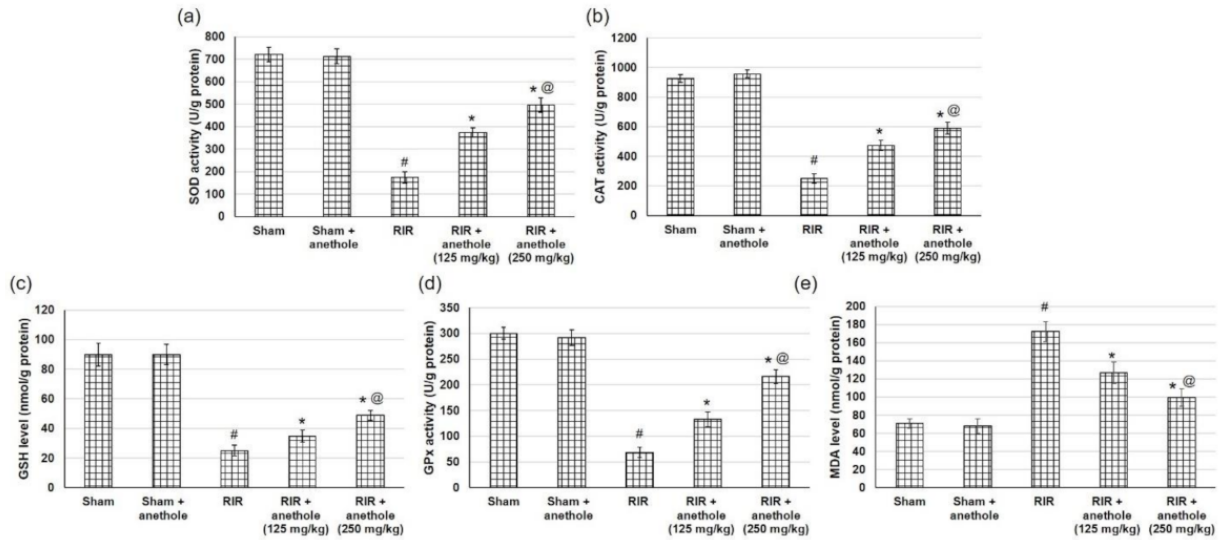
Figure 3. Effects of anethole (125 and 250 mg/kg) administration for 14 days prior to renal is- chemia/perfusion (RIR) on the renal oxidative stress ( a ) SOD, ( b ) CAT, ( c ) GSH, ( d ) GPx, and ( e ) MDA in RIR-induced injury. All values are stated as mean ± SD. # designates statistically sig- nificant compared to sham group, * designates statistically significant compared to RIR group, and @ designates statistically significant compared to RIR + anethole 125 mg/kg group ( p < 0.05) using one-way ANOVA followed by Tukey’s post hoc test.